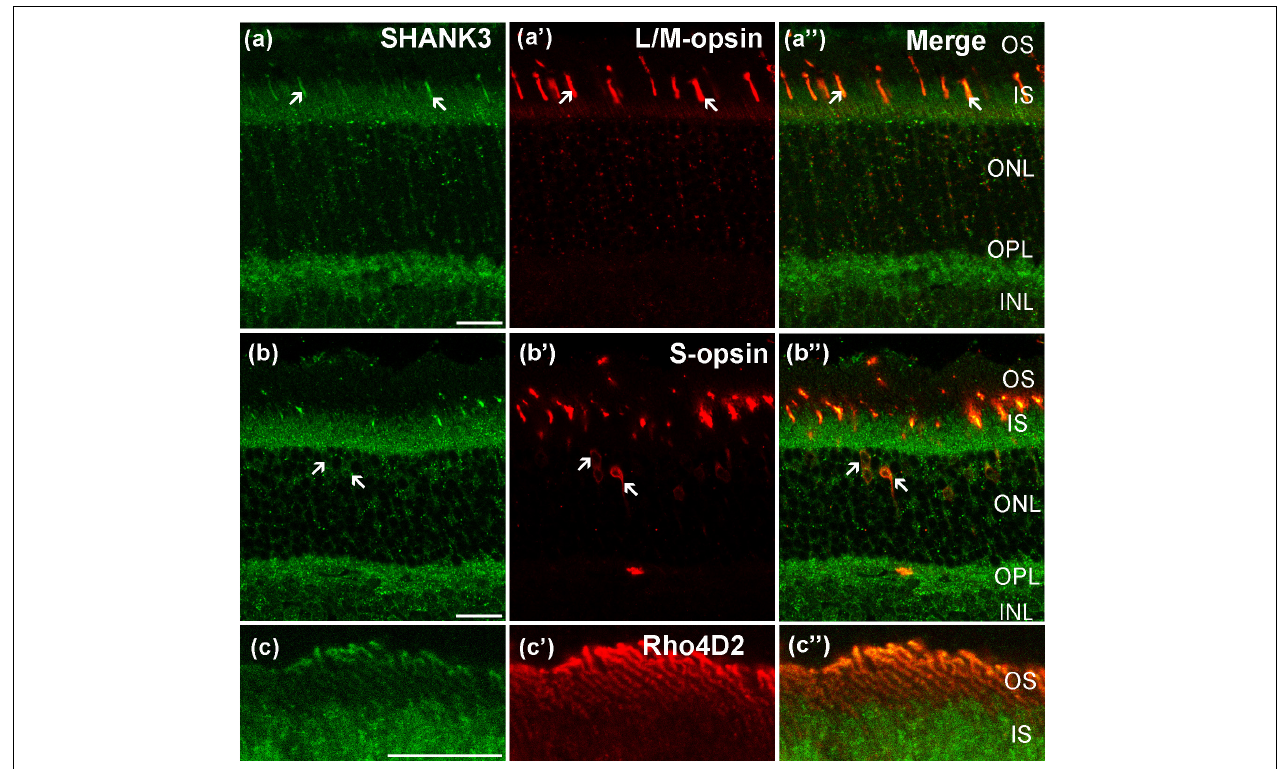
FIGURE 2 | Confocal microphotographs showing the distribution of SHANK3 in the photoreceptors. Double-labeled elements (green for SHANK3; red for L/M-opsin, S-opsin and Rho4D2) appear yellowish and some double-labeled cells are indicated by arrows. (a–a”) Colocalization of SHANK3 with L/M- opsin in a retinal vertical section. Fluorescence double stainings show that SHANK3 (a) and the L/M-opsin (a’) , the merged image of L/M-opsin and SHANK3 (a”) . L/M-opsin-labeled the outer segment (OS) of red/green cones (a’) . Part of the L/M-opsin-positive IS (arrows) are co-labeled by SHANK3 (a,a”) . (b–b”) Colocalization of SHANK3 with S-opsin in a retinal vertical section. Fluorescence double stainings show that SHANK3 (b) and the S-opsin (b’) , and b” is the merged image of S-opsin and SHANK3. S-opsin is a marker for blue cone. Note that labeling for SHANK3 is detected in S-opsin-positive blue cones (arrows). (c–c”) Colocalization of SHANK3 with Rho4D2 in a retinal vertical section. Fluorescence double stainings show that SHANK3 (c) and the Rho4D2 (c’) , the merged image of Rho4D2 and SHANK3 (c”) . Rho4D2-labeled the outer segment (OS) of rods (c’) . Rho4D2-positive OS are partially labeled by SHANK3 (c,c”) . OS, outer segment; IS, inner segment. Scale bar = 20 µ